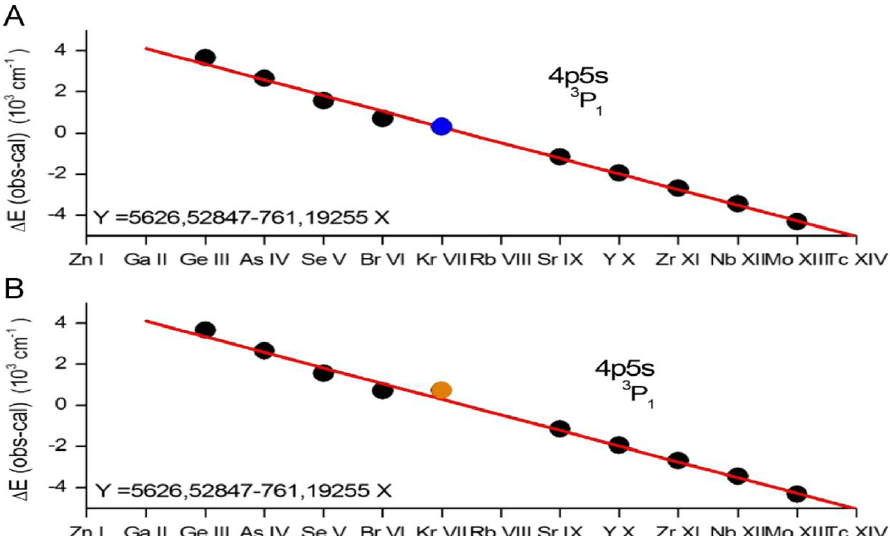
Figure 7. Interpolated value for the 4p5s 3 P 1 E obs –E cal of Kr VII in the Zn-like sequence. Our new adjusted energy difference value represented in A fits better than the value reported in Ref. [58], as shown in B . Reproduced by permission of IOP Publishing from [57] (© The Royal Swedish Academy of Sciences. All rights reserved.)